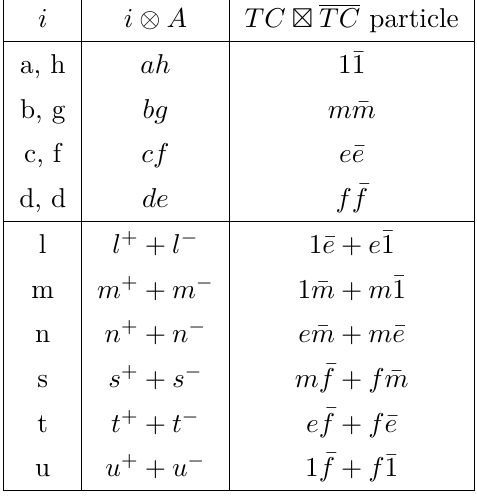
Table 10 . Identify child theory of A = a + h condensation with TC (cid:2) TC .